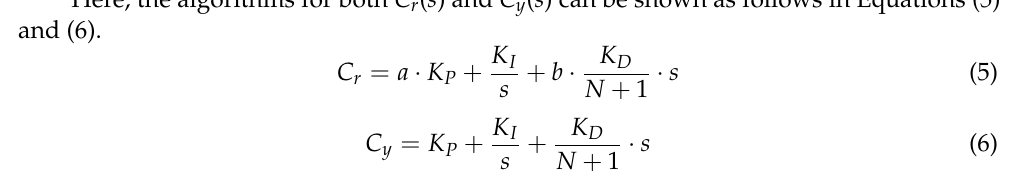
Figure 6. A block diagram of 2DOF PID controller.